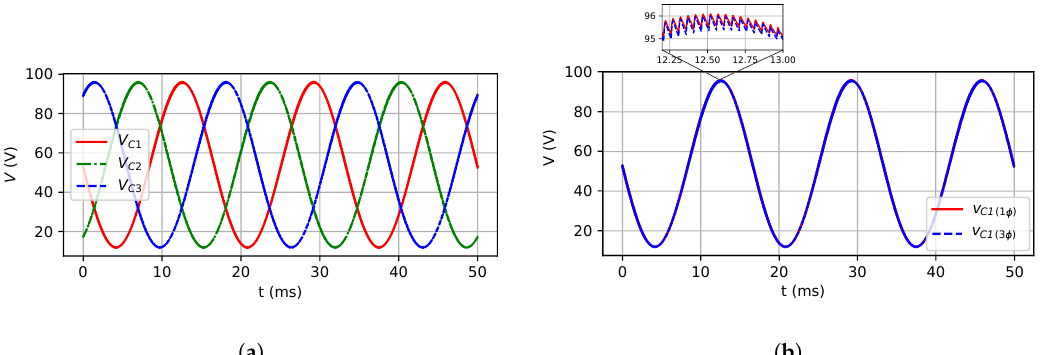
Figure 19. Capacitor voltages for RC load case: ( a ) Three-phase model; ( b ) Single-phase and three-phase (leg 1) models.